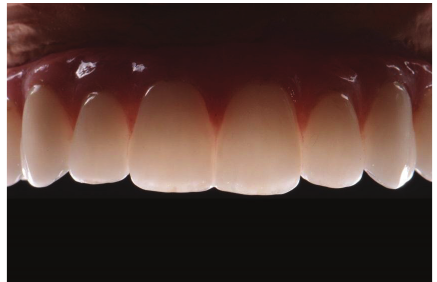
Figure 9: Translucency effect in the anterior maxilla after applica- tion of ceramics in the digital cut back.